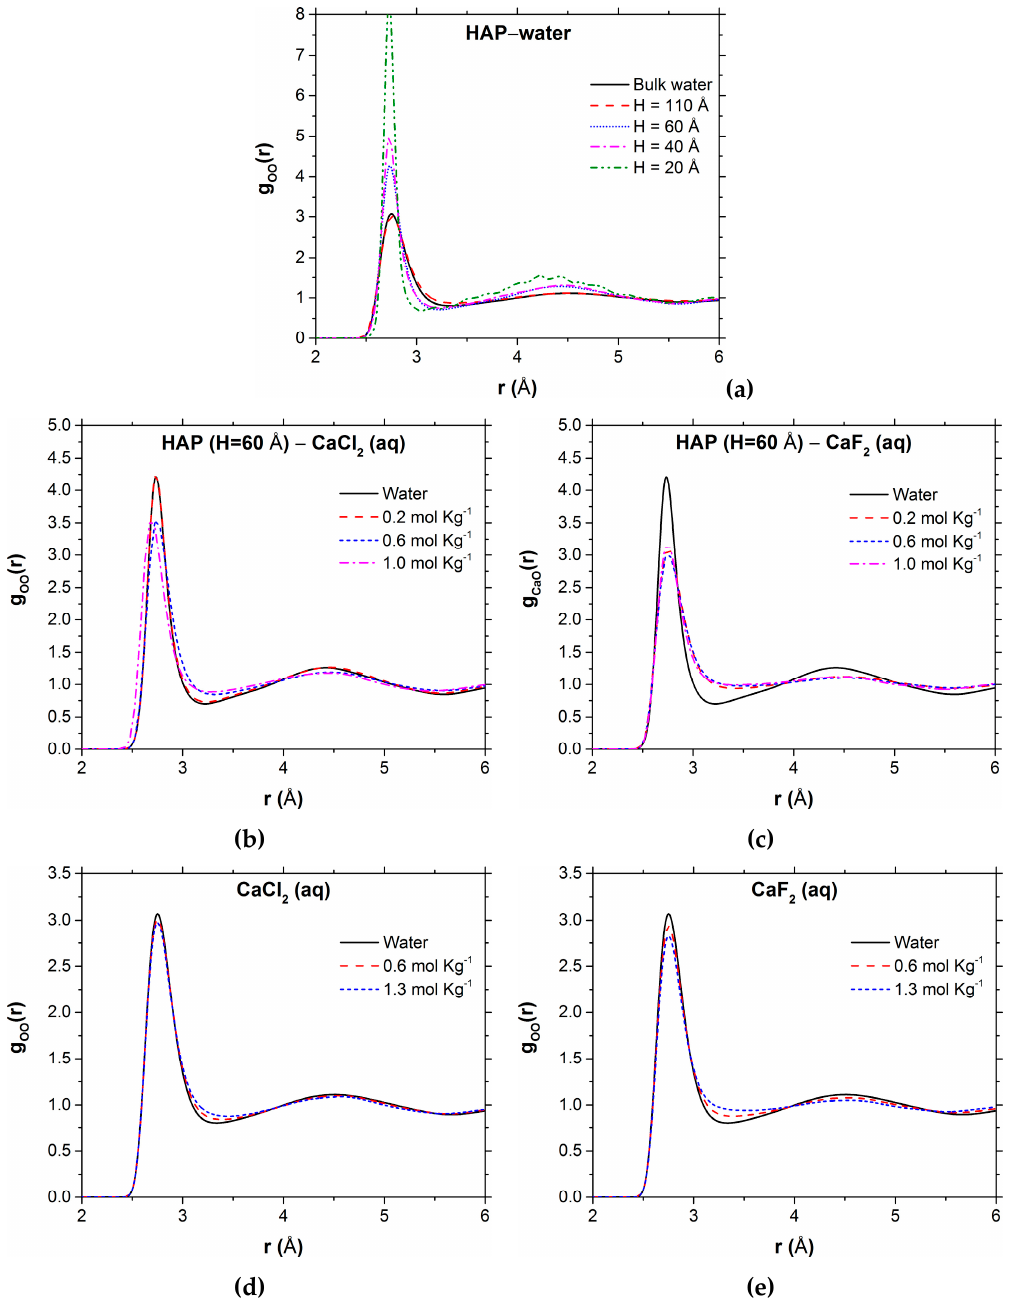
Figure 2. Oxygen–oxygen (O–O) radial distribution functions (g OO (r)) of water molecules. ( a ) Bulk water and HAP nanopores–water (20 Å ≤ H ≤ 110 Å). ( b ) HAP nanopore (H = 60 Å)–CaCl 2 solutions. ( c ) HAP nanopore (H = 60 Å)–CaF 2 solutions. ( d ) Bulk water and aqueous CaCl 2 solutions. ( e ) Bulk water and aqueous CaF 2 solutions.